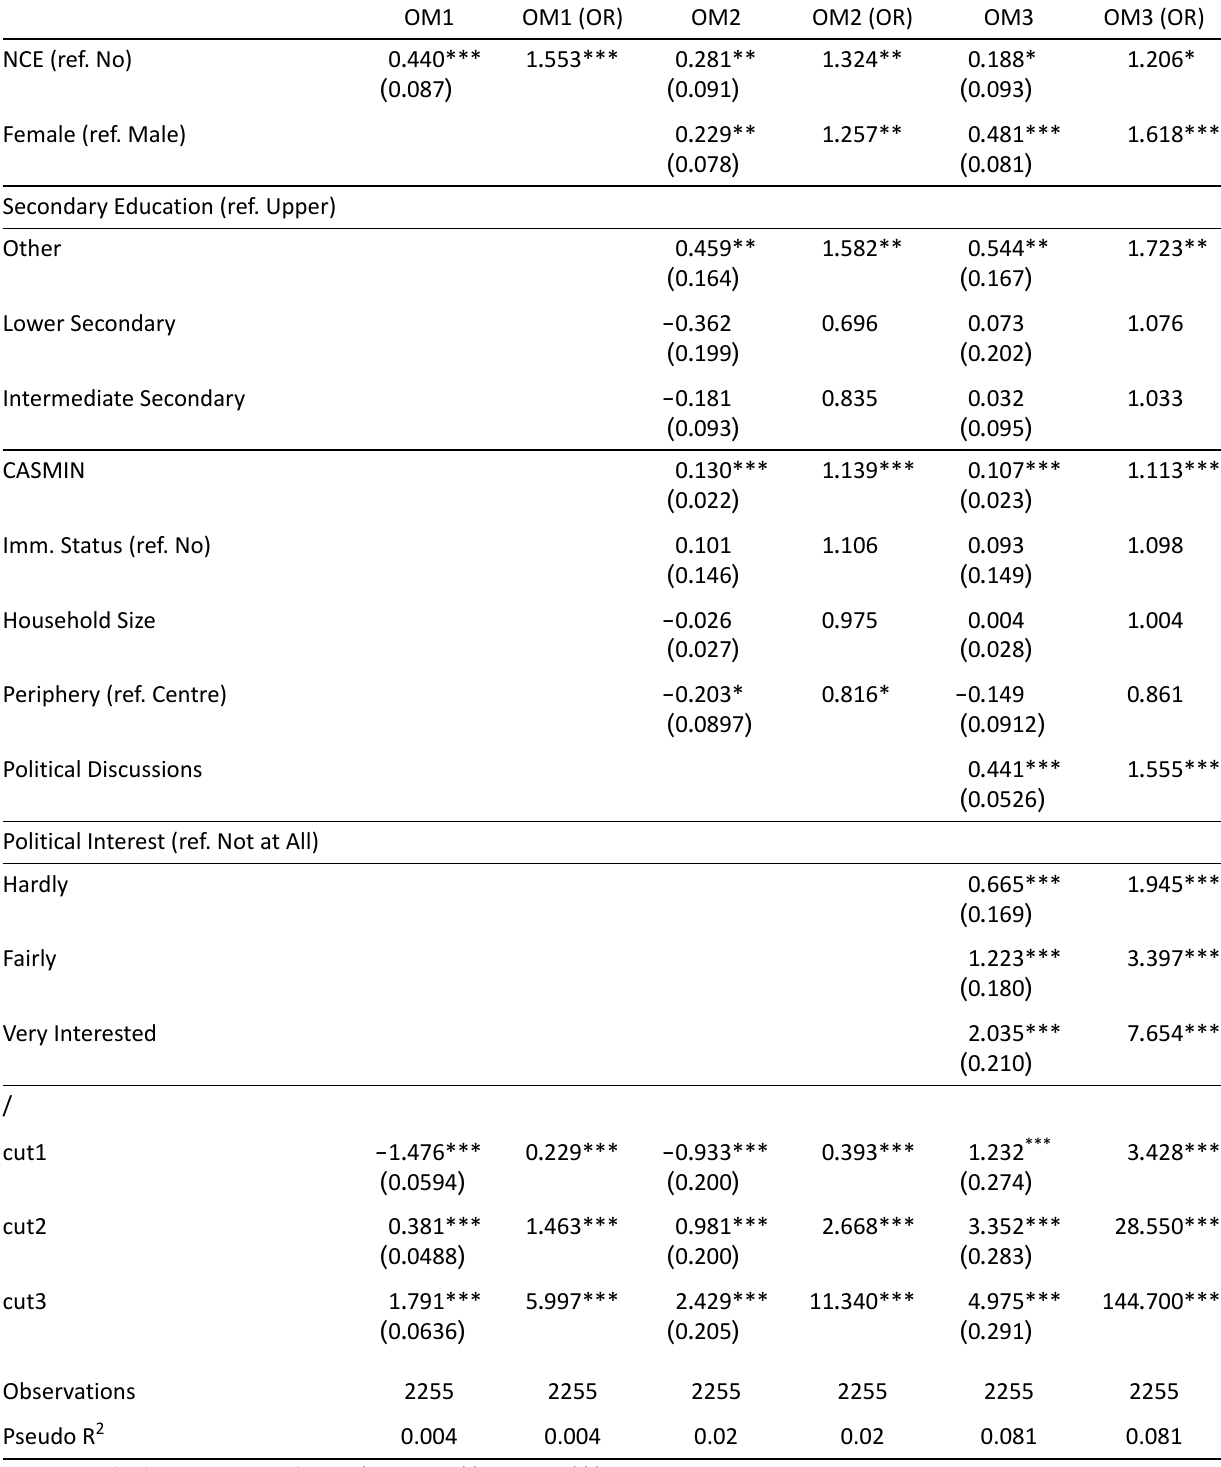
Table 2. Ordered logistic regressions on potential protest participation. OM1 OM1 (OR) OM2 OM2 (OR) OM3 OM3